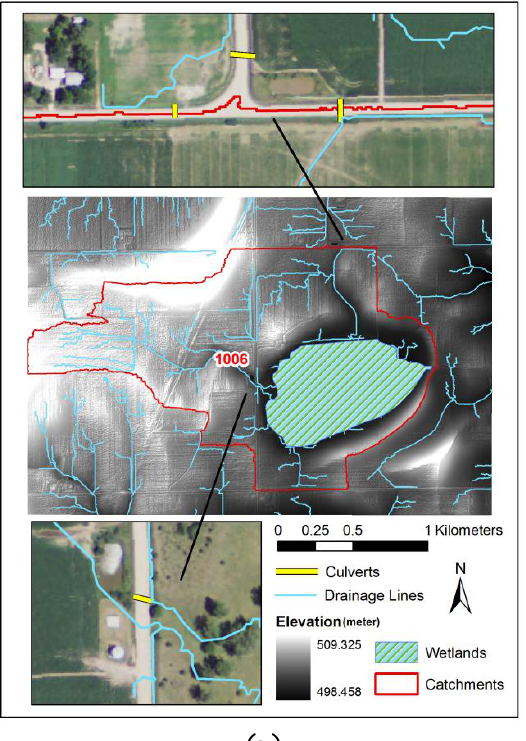
Figure 5. Simulated catchments and drainage lines for Modeling Area 2. ( a ) Did not incorporate culvert information, and ( b ) incorporated culvert information in